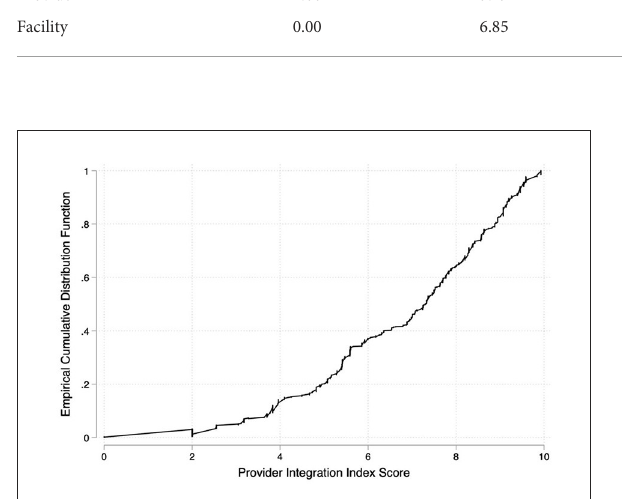
FIGUREA1 Provider integration index cumulative distribution.